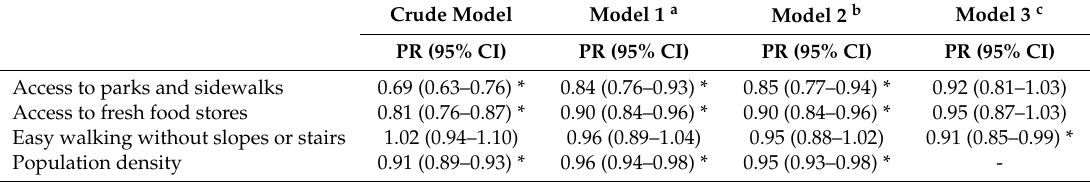
Table 3. Association between neighborhood walkability and knee pain by multilevel Poisson regression analysis ( n = 22,892).